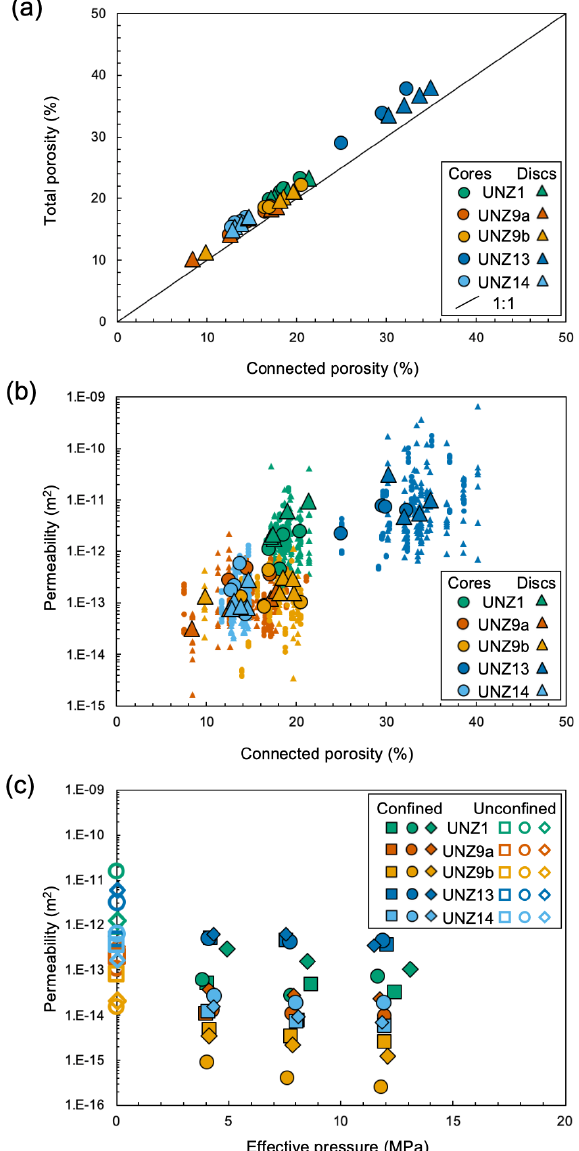
Figure 4. Physical attributes of tested dacite samples: (a) total ver- sus connected porosity for the core and disc samples chosen for mechanical testing (complete dataset available in Table S1) with the 1 : 1 line highlighting the degree of connectivity; (b) unconfined permeability as a function of connected porosity showing 1065 in- dividual measurements of cores and discs (small symbols; see Ta- ble S1) measured using a gas minipermeameter overlain by the av- erage permeability of the samples selected for mechanical testing (large symbols); (c) unconfined and confined permeability as a func- tion of effective pressure for three cores of each material, uncon- fined permeability estimates correspond to those in panel (b) and confined measurements use water as the pore fluid in a pressure vessel (also plotted as a function of porosity in Fig. S3). Solid Earth, 12, 633–664,